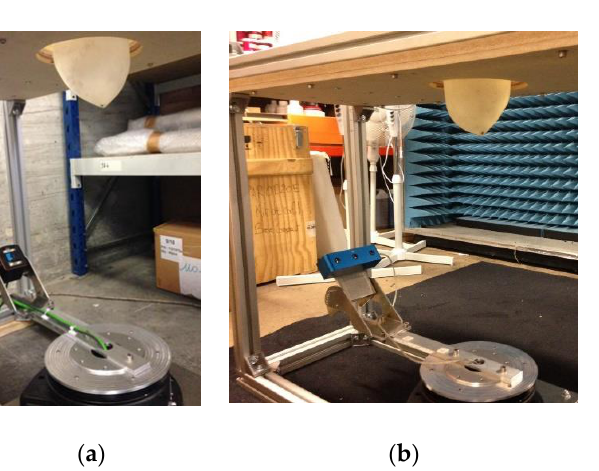
Figure A1. Azimuthal rotating camera system: ( a ) Experimental test setup for IFM O3D302 camera; ( b ) Experimental test setup for Ensenso N10-804-18